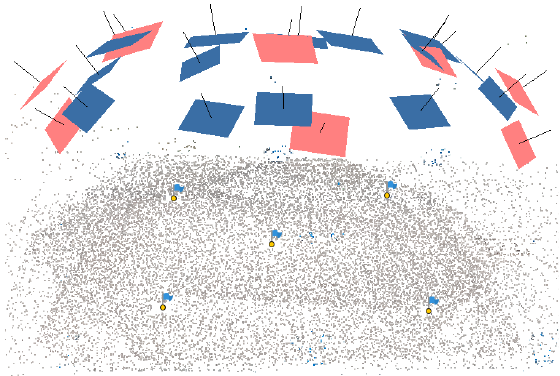
Figure 3: On-the-field calibration for the lever-arm estimation in the static